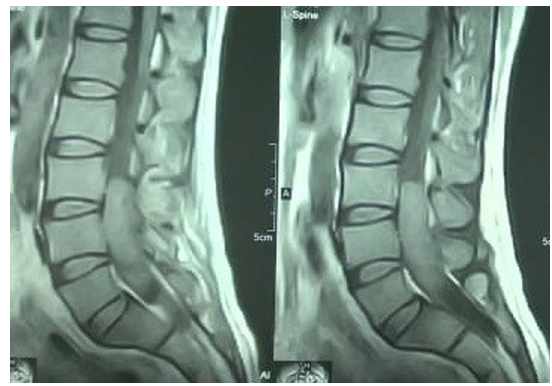
Fig. 1 The magnetic resonance imaging of the lumbosacral spine